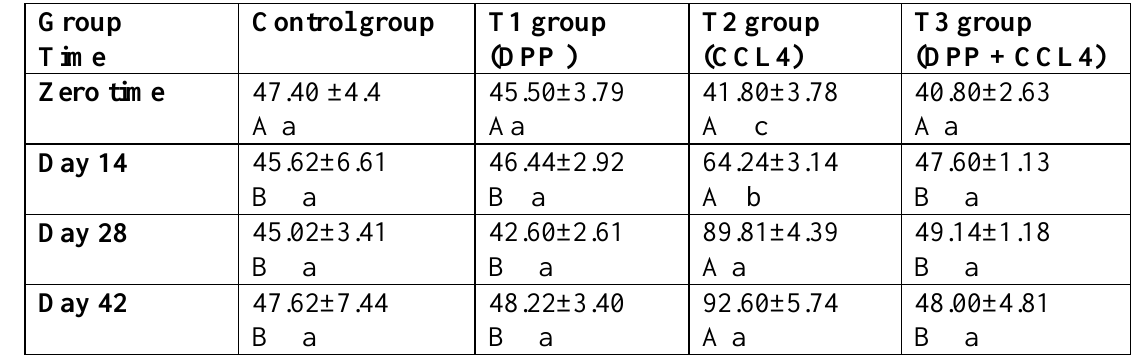
Table (3): Effect of DPP, CCL4 and DPP plus CCL4 on ALT activity (IU/L) of adult male rats.